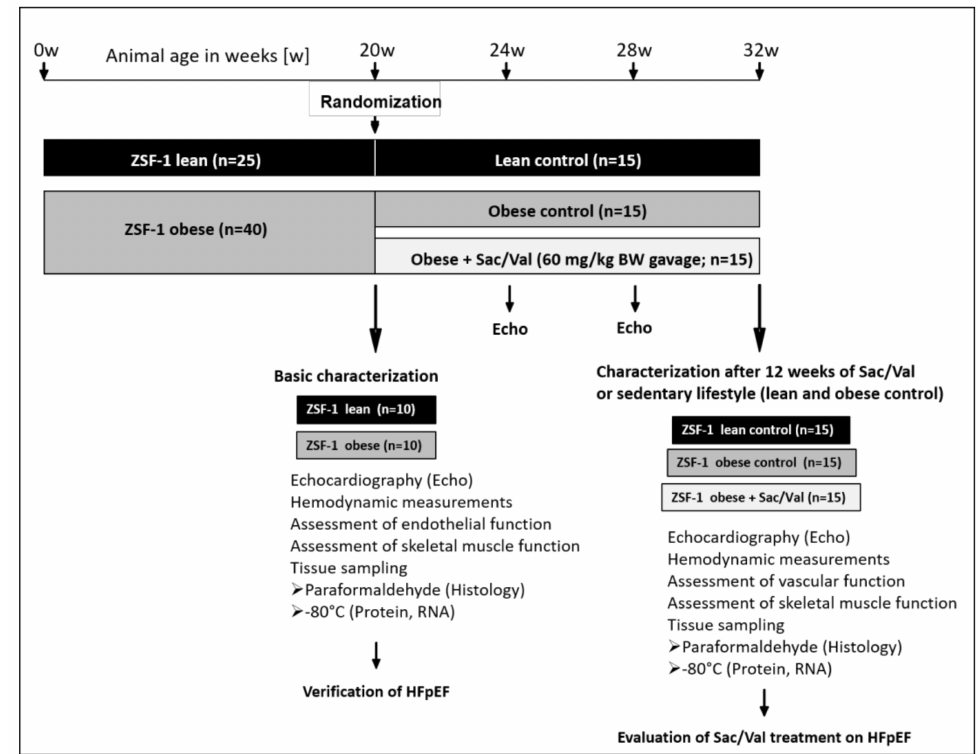
Figure 9. Study design. In the present study, a total number of 25 ZSF1-lean and 40 ZSF1-obese rats was included. At an age of 20 weeks, 10 lean and 10 obese rats were randomly selected for baseline characterization. The remaining obese rats were randomly divided into two equal sized groups with n = 15 receiving a daily oral gavage of Sac/Val (60 mg/kg/day, LCZ696, Novartis, Germany) over a time period of 12 weeks (Sac/Val) and n = 15 serving as sedentary obese control. The 15 lean rats served as sedentary lean